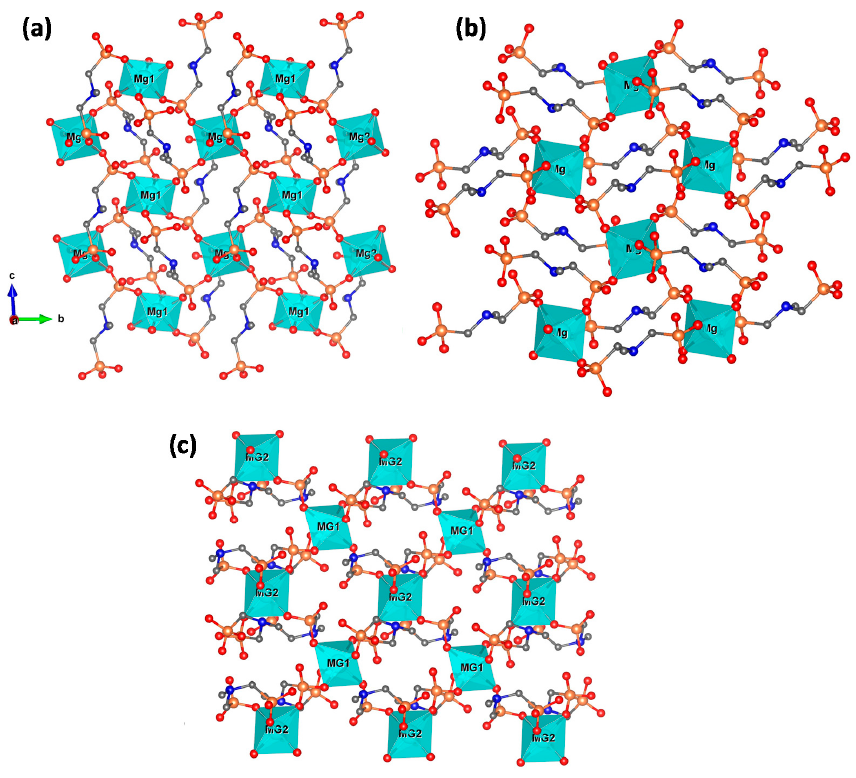
Figure 4. Representation of the layers for Compounds 1 ( a ), 1deh ( b ), and 2 ( c ) [28].